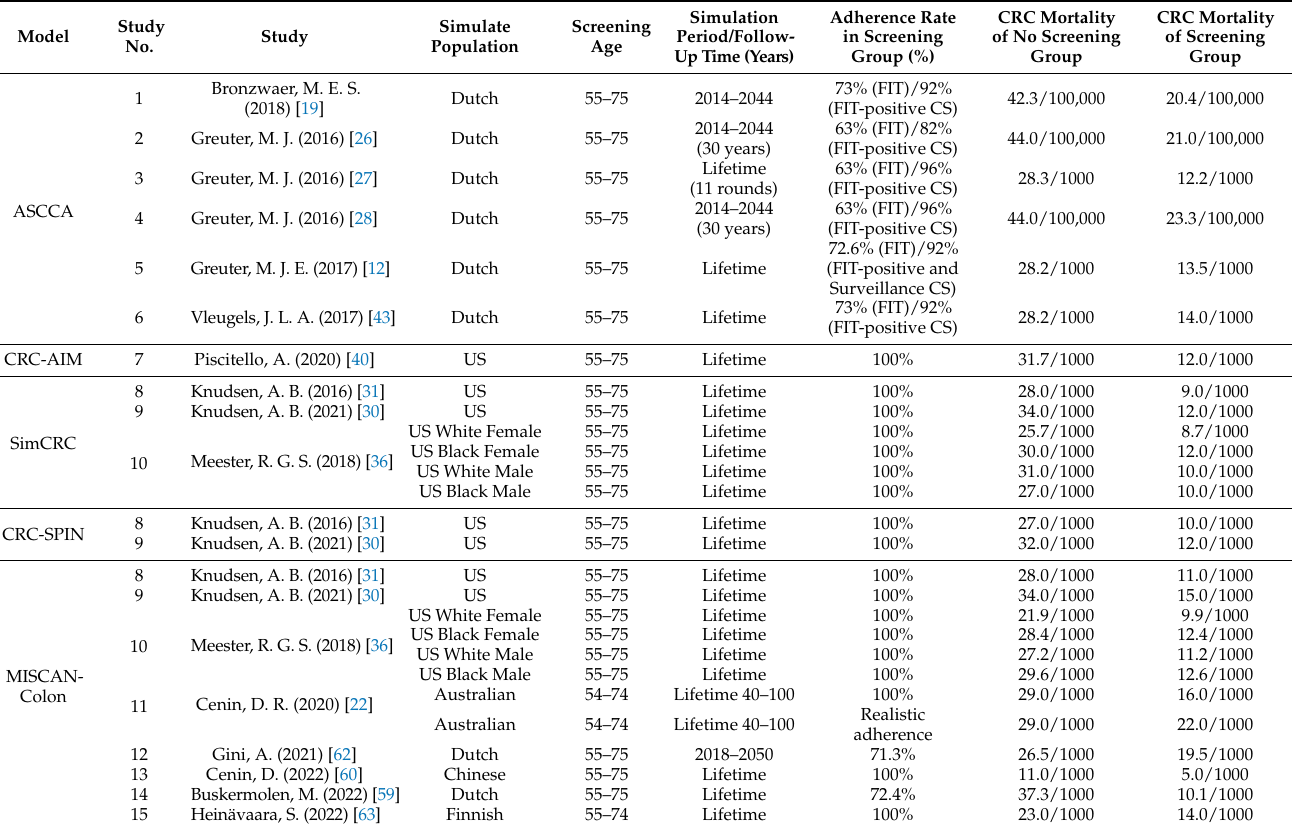
Table 3. Characteristics of simulation models on biennial FIT screening from the age of 55 to